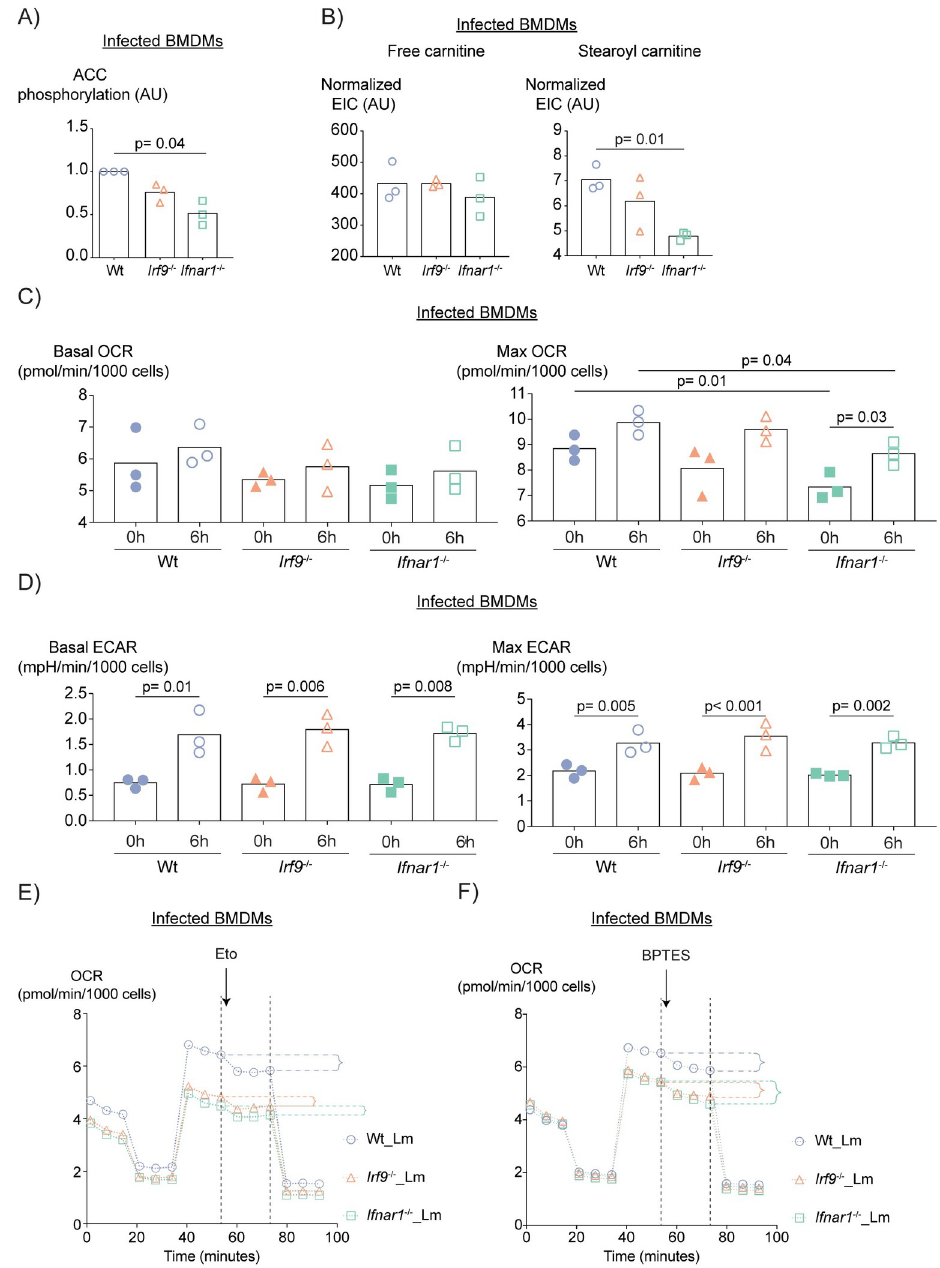
Fig 2. L . monocytogenes infection and Ifnar1 deficiency lead to glutaminolysis and FAO changes in BMDMs. (A) Quantification of ACC phosphorylation of BMDMs 6h post-infection. P value was calculated using ANOVA with Geisser-Greenhouse correction. (B) Extracted ion count (EIC) levels of carnitine and stearoyl carnitine normalized to tubulin levels as detected by WB of BMDM lysates 6h post-infection. P value was calculated using ANOVA corrected for multiple testing with Tukey’s post-hoc test. (C) OCR (Oxygen Consumption Rate) and (D) ECAR (Extracellular Acidification Rate) of wt, Irf9 -/- and Ifnar1 -/- BMDMs uninfected or 6h post- infection. Each data point represents one biological replicate. Bars show the mean values. P values were calculated using two-way ANOVA and corrected for multiple testing with Sidak and Dunnett’s post-hoc tests. Bars show the mean values. Mean OCR of four replicates of (E) Etomoxir- and (F) BPTES-treated L . monocytogenes infected BMDMs. The inhibitors were added at the time point indicated by the arrow. OCR differences (shown with braces) were calculated using OCR values measured at 73 min (addition of Rotenone/Antimycin) and 53 min (indicated with dashed